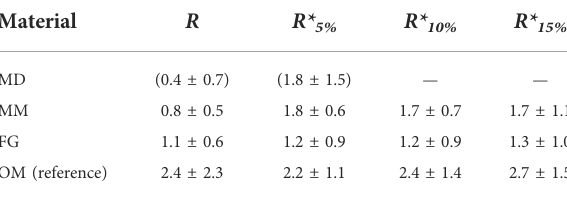
TABLE 1 Anisotropy of cellular migration in the 2D layer and 3D spheroid assays expressed by the ratios R and R* , respectively. Material